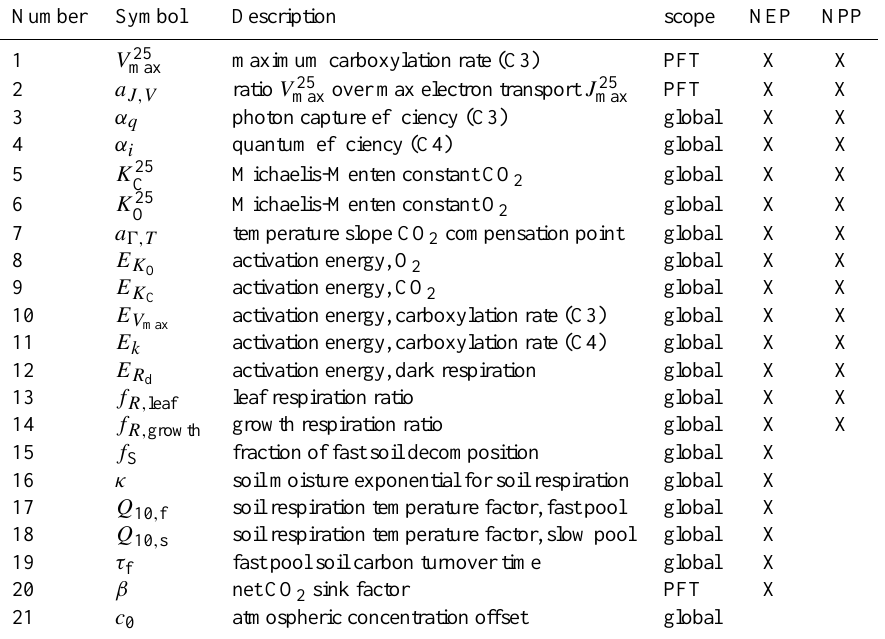
Table 2. Process parameters, their symbols (2nd column), their description (3rd column), whether their scope is PFT specific or global (4th column), whether NEP (5th column) or NPP (6th column) are sensitive to them.